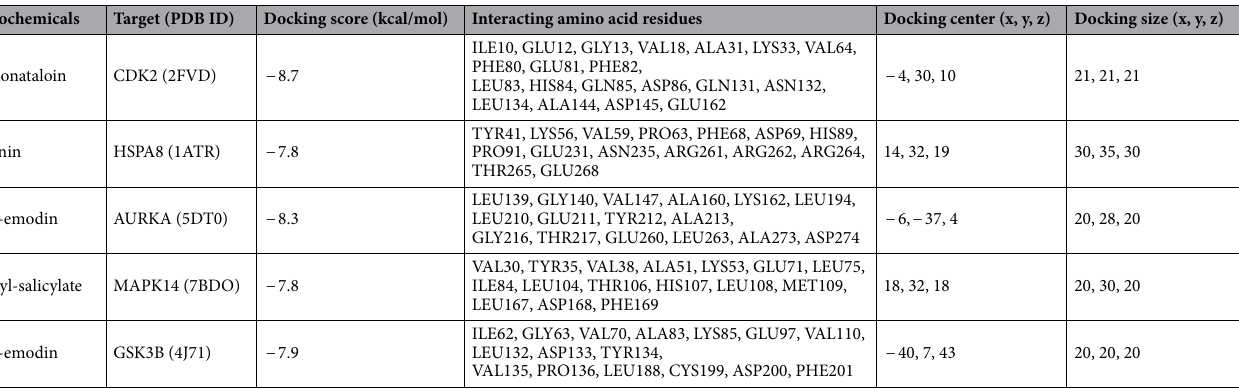
Table 4. Binding affinity energies, interacting amino acid residues, docking center and docking size between selected phytochemicals and targets.